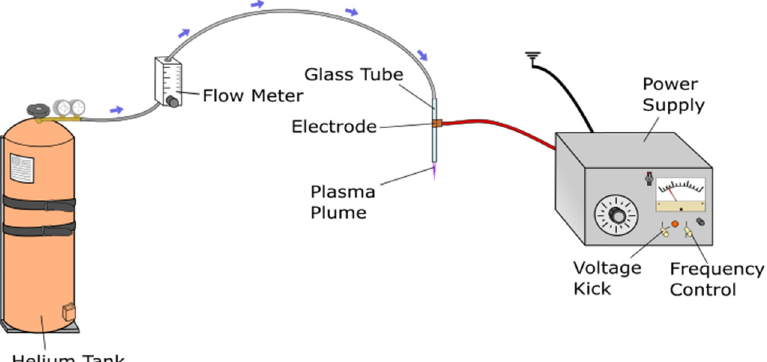
Figure 1. Schematic of cold atmospheric plasma (CAP) source used for the treatment of the Ultra- High-Molecular-Weight Polyethylene (UHMWPE) samples.